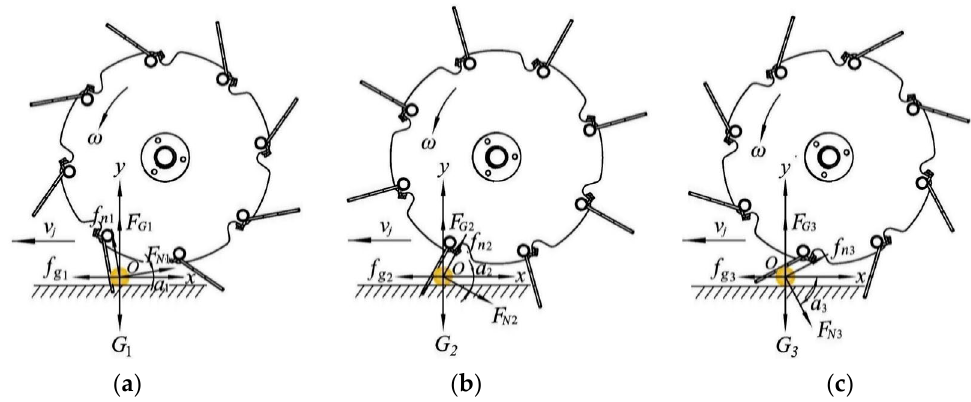
Figure 10. Force analysis of straw at the moment when spring teeth start to touch under three in- stallation types. ( a ) Forward inclination; ( b ) Radial; ( c ) Backward inclination. Note: G 1 , G 2 and G 3 are the gravity of maize straw under the three installation types, respectively, N; F N 1 , F N 2 and F N 3 are the thrust of spring teeth on maize straw when they are picked up, respectively, N; F G 1 , F G 2 and F G 3 are the supporting forces of the ground to maize straw respectively, N; f g 1 , f g 2 and f g 3 are the friction between the ground and maize straw, respectively, N; f n 1 , f n 2 and f n 3 are the friction between the spring teeth and maize straw, respectively, N; α 1 , α 2 , and α 3 are the included angles between the thrust F N 1 , F N 2 , F N 3 , and the x -axis, °.